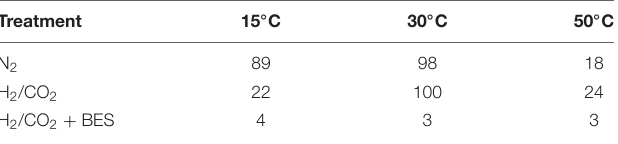
Frontiers in Microbiology |